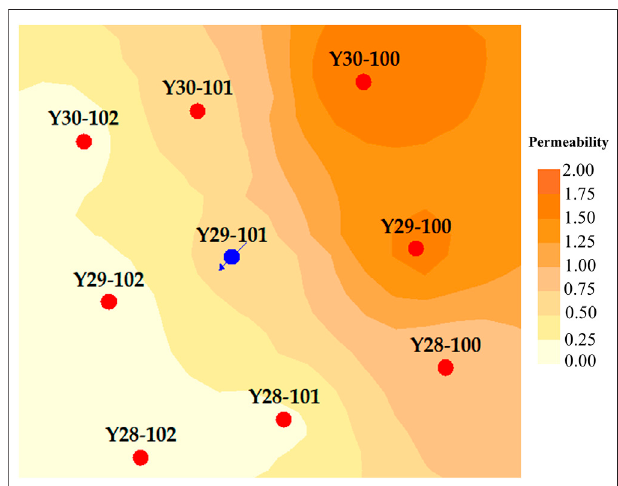
FIGURE 8 | Diagram of CO 2 displacement experimental results. FIGURE 9 | Permeability distribution of Y29-101 well